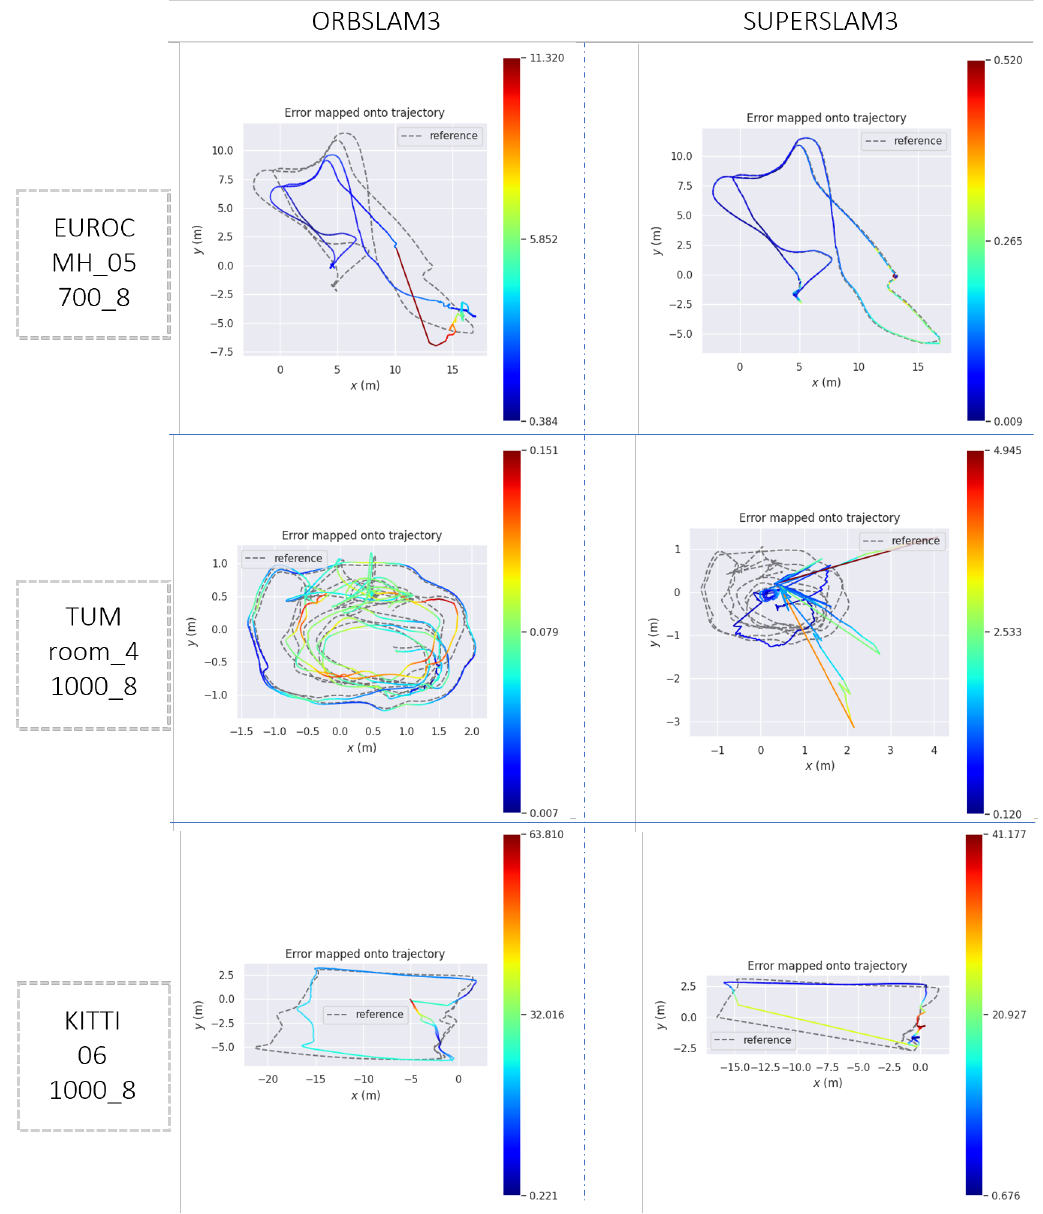
Figure 3. Sample trajectories comparisons using EVO tools shows that, while SUPERSLAM3 out- performed ORBSLAM3 in terms of ATE and ARE for the EuRoC MH_05 sequence with nFeatures and nLevels set to 700 and 8, respectively, it performed significantly worse than ORBSLAM3 for the room_4 sequence (TUM-VI) with nFeatures and nLevels set to 1000 and 8, respectively. Both algorithms also showed poor performance for the KITTI dataset, particularly in terms of